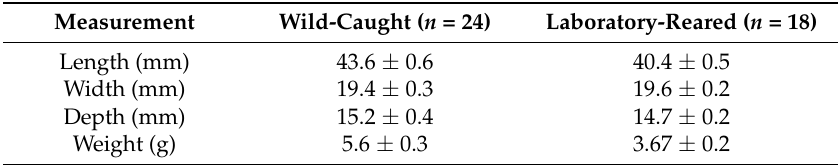
Table 2. Average ( ± SE) body biometrics for